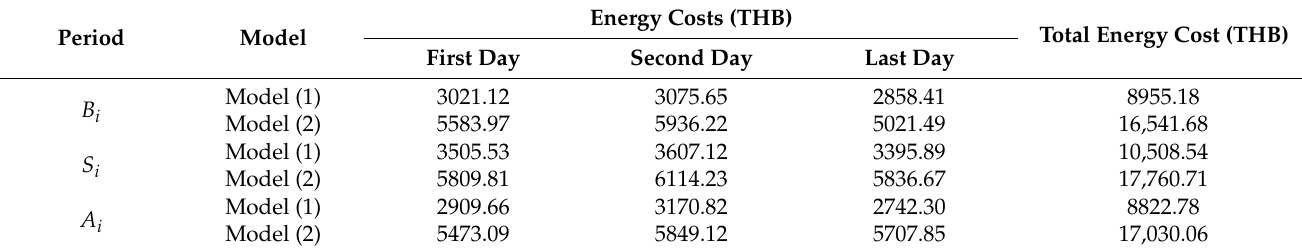
Table 11. Energy costs of the three periods for the two models.